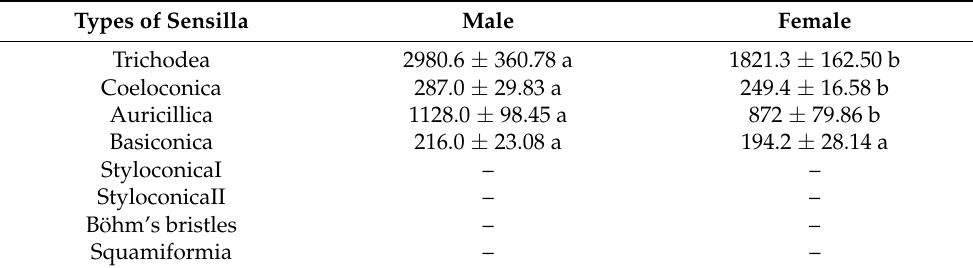
Table 3. Estimated number of antennal sensilla in D. rubella